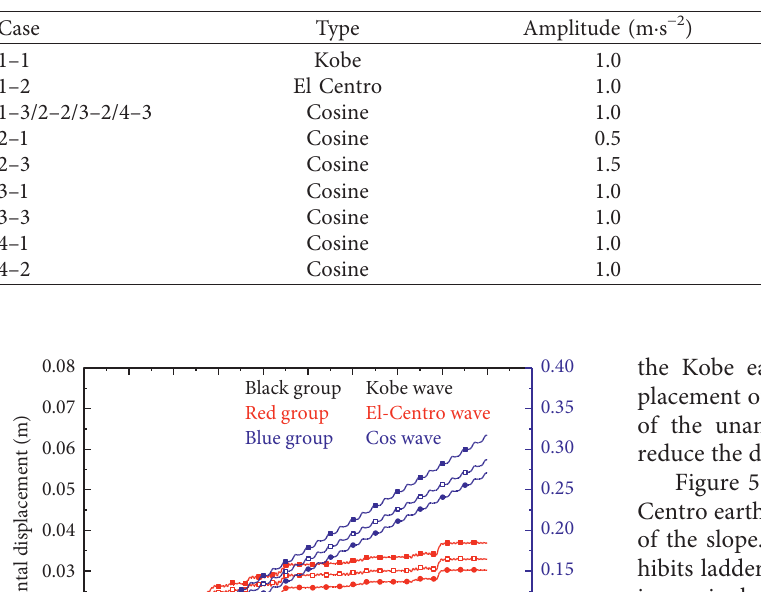
Figure 3: Input acceleration. Table 3: Parameters of input waves under simulation conditions.